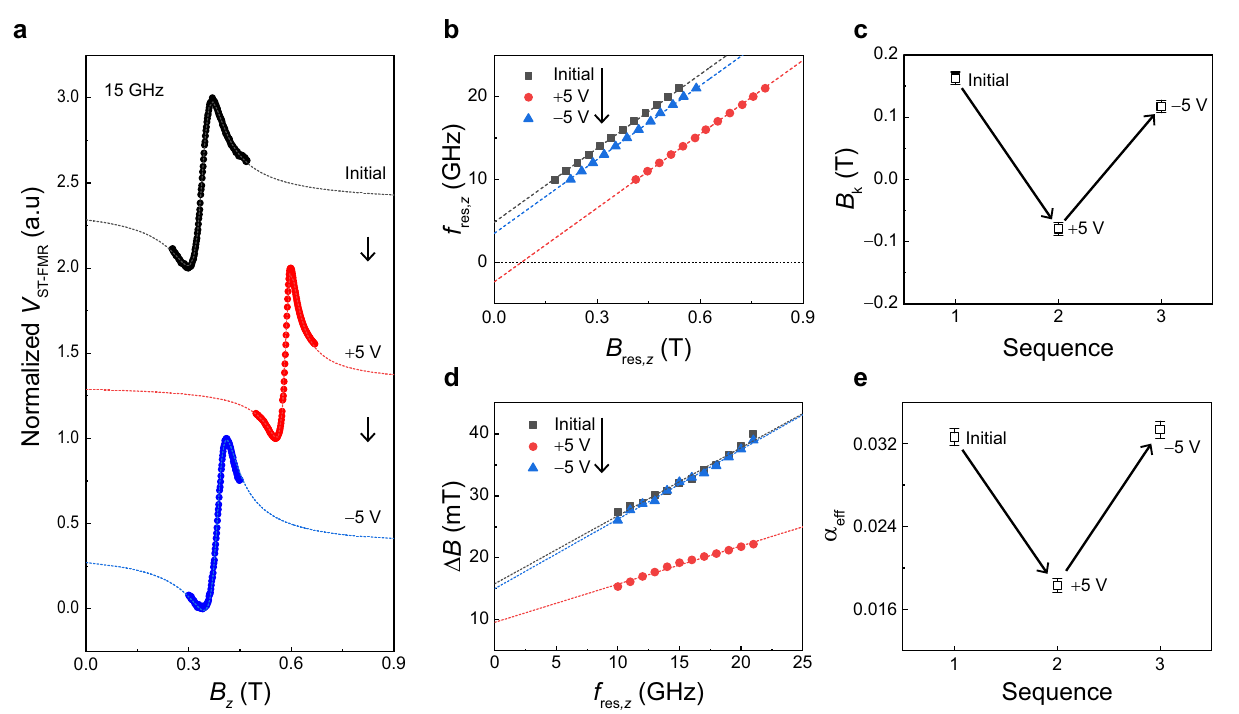
Fig. 2 Voltage-dependent ST-FMR spectra. a ST-FMR spectra of the Co/Ni sample for sequentially applied gate voltages (initial, + 5 V, and − 5 V). Here, the microwave frequency is 15 GHz. The dotted lines are the best fi ts based on Eq. (1). b Resonance frequency ( f res ; z ) as a function of resonance fi eld B res ; z of the sample with different sequentially applied gate voltages. c Variation of perpendicular magnetic anisotropy fi eld ( B k ) versus sequentially applied gate voltage, where the error bars are due to the uncertainty in fi tting the data in Fig. 2b to the Kittel formula, f res ; z ¼ γ Lorentzian function ( 4 B ) as a function of the f res ; z of the sample with sequentially applied gate voltages. e Variation of effective damping constant ( α eff ) versus sequentially applied gate voltage, where the error bars are due to the uncertainty in fi tting the data in Fig. 2d to the equation, 4 B ¼ 4 B 0 þ 2 πα eff γ f res ; z